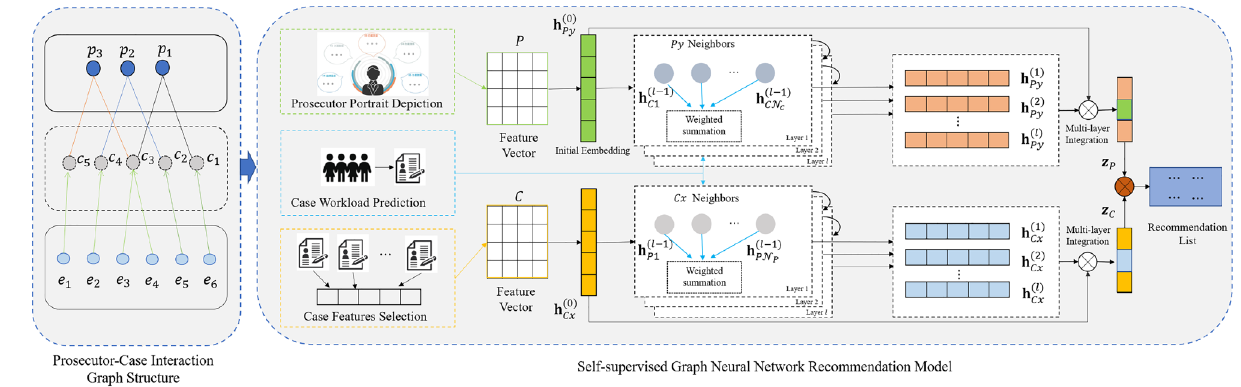
Figure 1. Overview of the proposed SGPGRec framework.